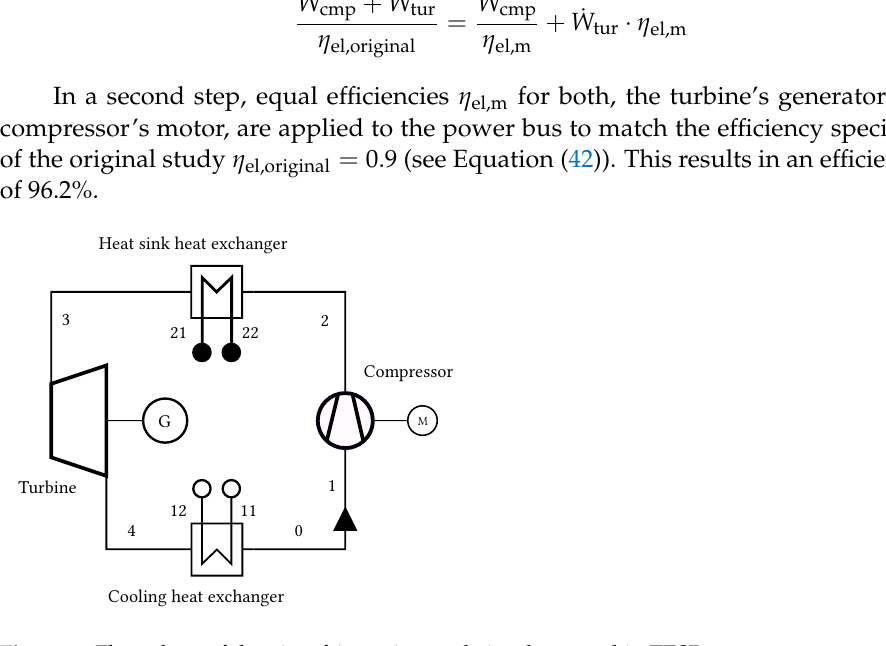
Figure 9. Flow chart of the air refrigeration cycle implemented in